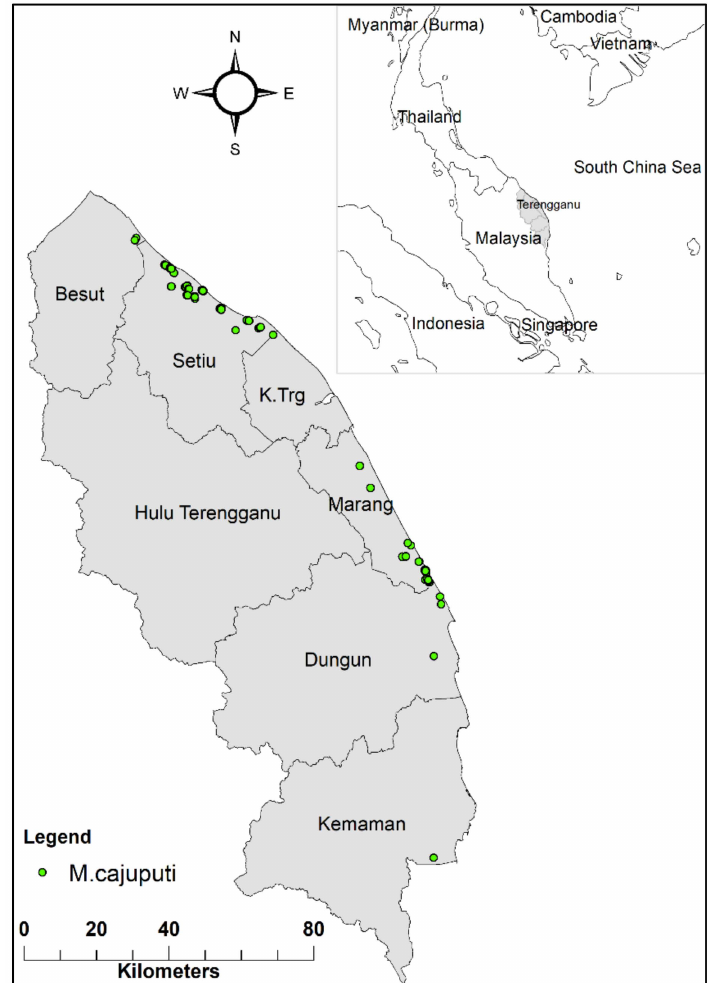
Figure 1. Location of Terengganu (gray color) in the Northeast of Peninsular Malaysia. The green dots represent the occurrence of M. cajuputi clusters recorded during the field surveys in 2018 and